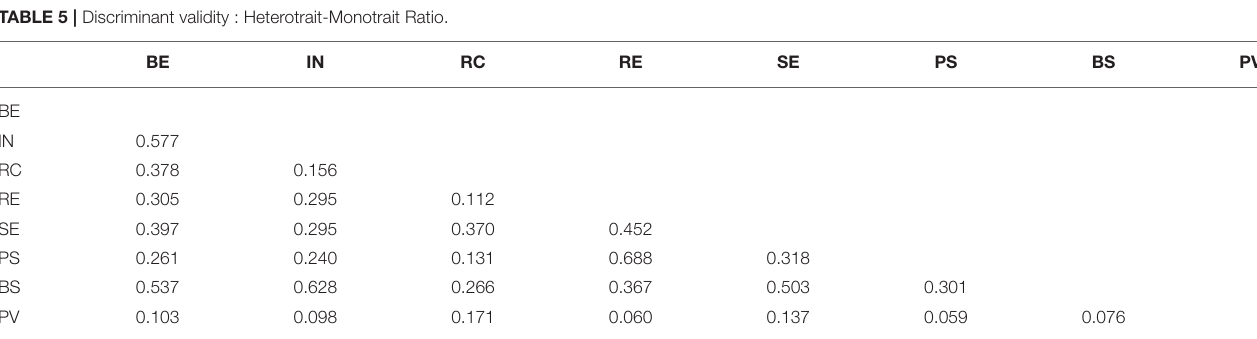
TABLE 5 | Discriminant validity : Heterotrait-Monotrait